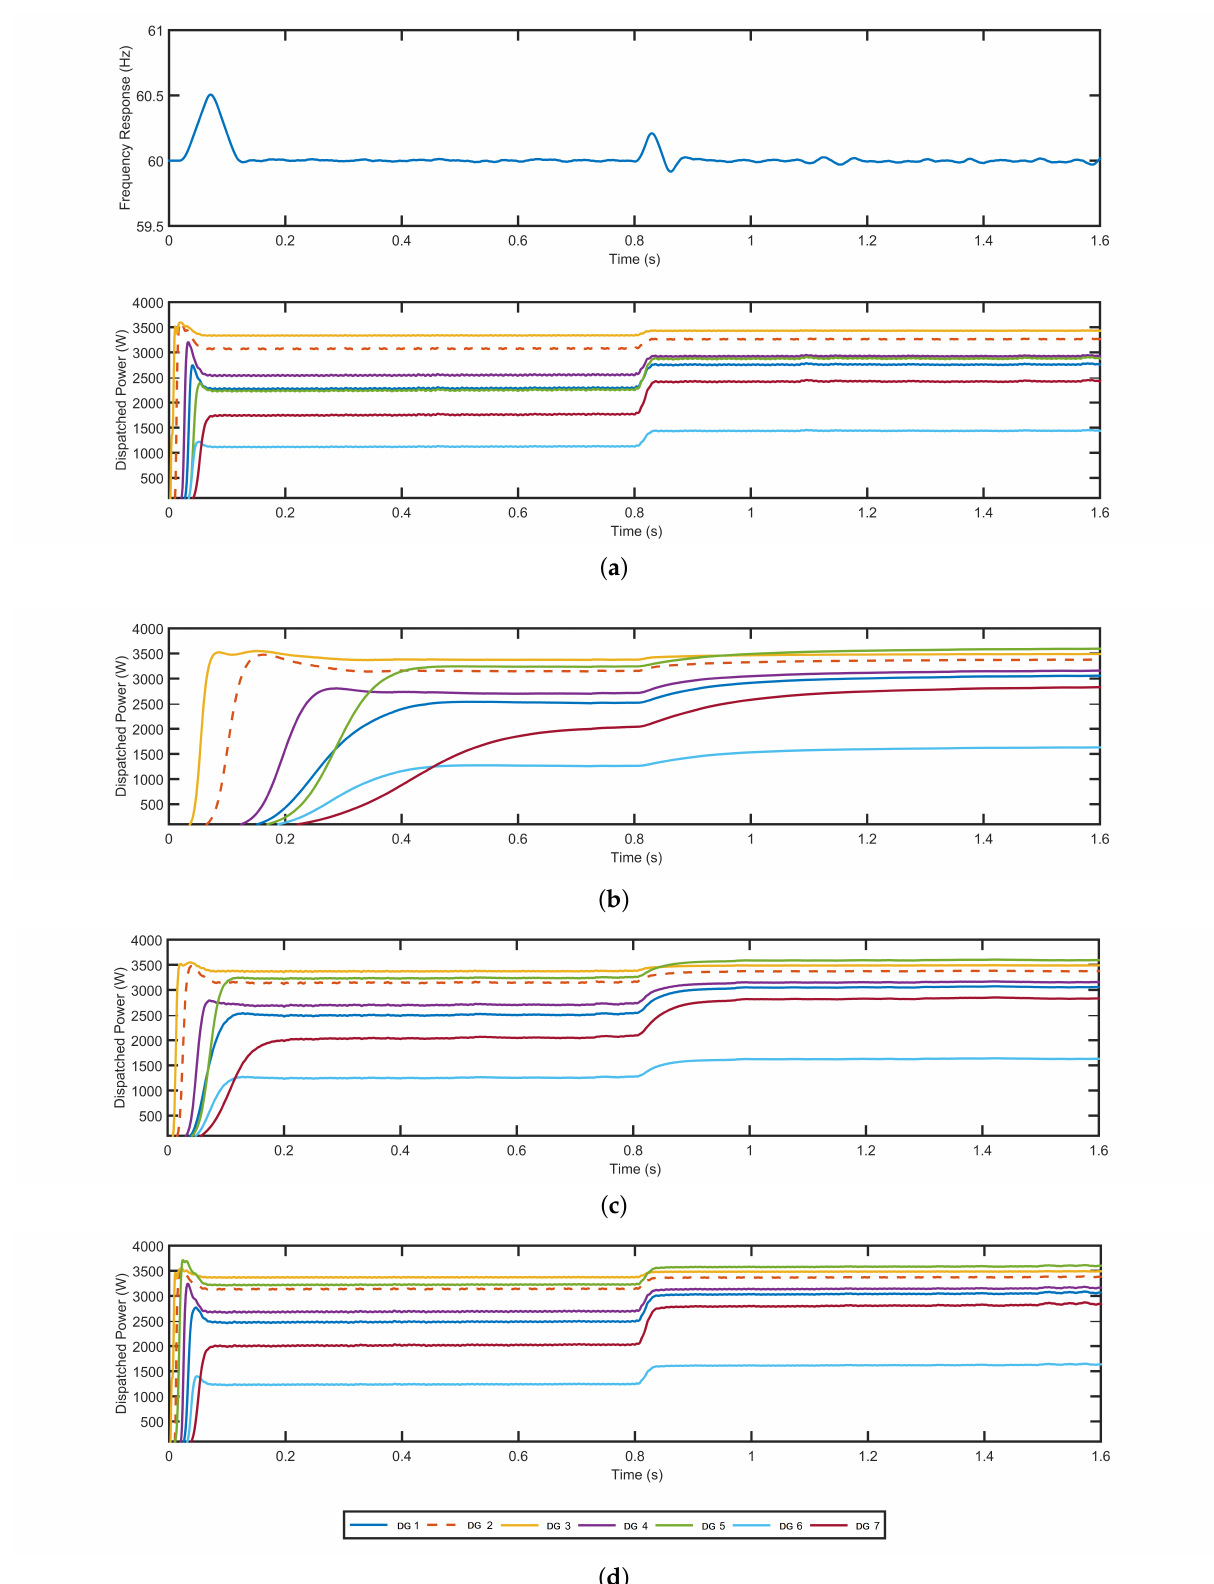
Figure 6. Results for a microgrid test system. ( a ) Frequency response and active power response of DGs for the classic RD. The evaluation of the behavior of the Boltzmann-based distributed replicator dynamics is shown for different values of τ as follows: ( b ) τ = 0.5 ( c ) τ = 2, ( d ) τ =